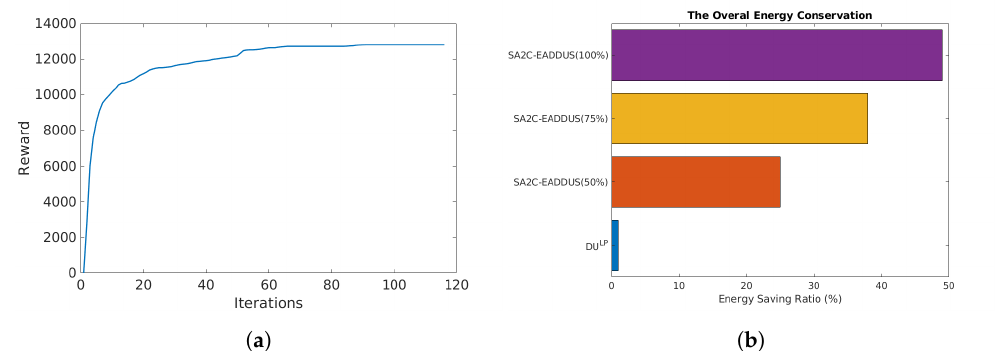
Figure 3. The convergence of the reward function and the overall energy conservation in the network when the SA2C-EADDUS with different processing capacity level is employed: ( a ) the convergence of the reward function; ( b ) impact of changing ξ in